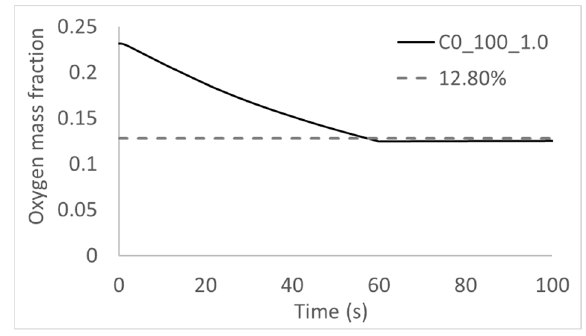
Figure 4. Oxygen mass fraction vs. time for the case C0_100_1.0.